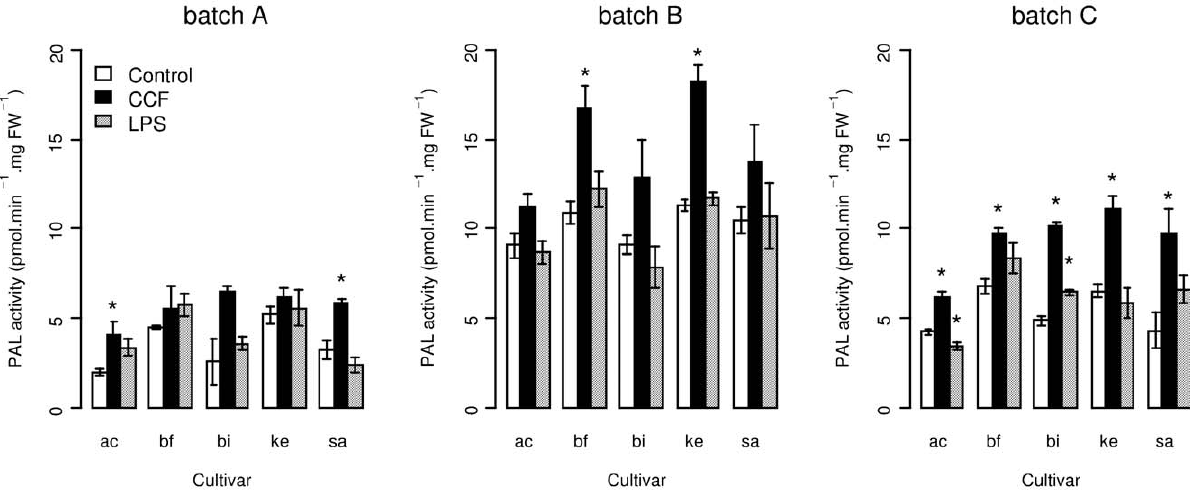
Figure 2. Phenylalanine ammonia-lyase activity in protein extracts from elicitor-treated parenchymatous potato tuber tissue. Activity was measured after 7.5 h of contact with either water as the control (white bars) or elicitors such as a concentrated culture filtrate (CCF) from Phytophthora infestans (black bars) or purified lipopolysaccharides (LPS) from Pectobacterium atrosepticum (grey bars). Potato cultivars (ac=Ackersegen, bf=BF15, bi=Bintje, ke=Kerpondy, sa=Saturna) used were produced in 2008 and 2009. Tubers produced in 2008 were used after 8 months of storage (batch A), tubers produced in 2009 were used after 2 months (batch B) and after 10 months (batch C) of storage. Data for batch C are means from two replicate experiments (vs. one for batches A and B); in each experiment, for each cultivar and treatment, four disks from different tubers were pooled and aliquoted to constitute four different samples. Bars represent the means 6 standard error of phenylalanine ammonia-lyase activity in at least two samples per treatment and cultivar combination. Stars above bars indicate significant differences between the control and tuber tissue treated with the concentrated culture filtrate or lipopolysaccharides, respectively (Dunnett’s test, p , 0.05).